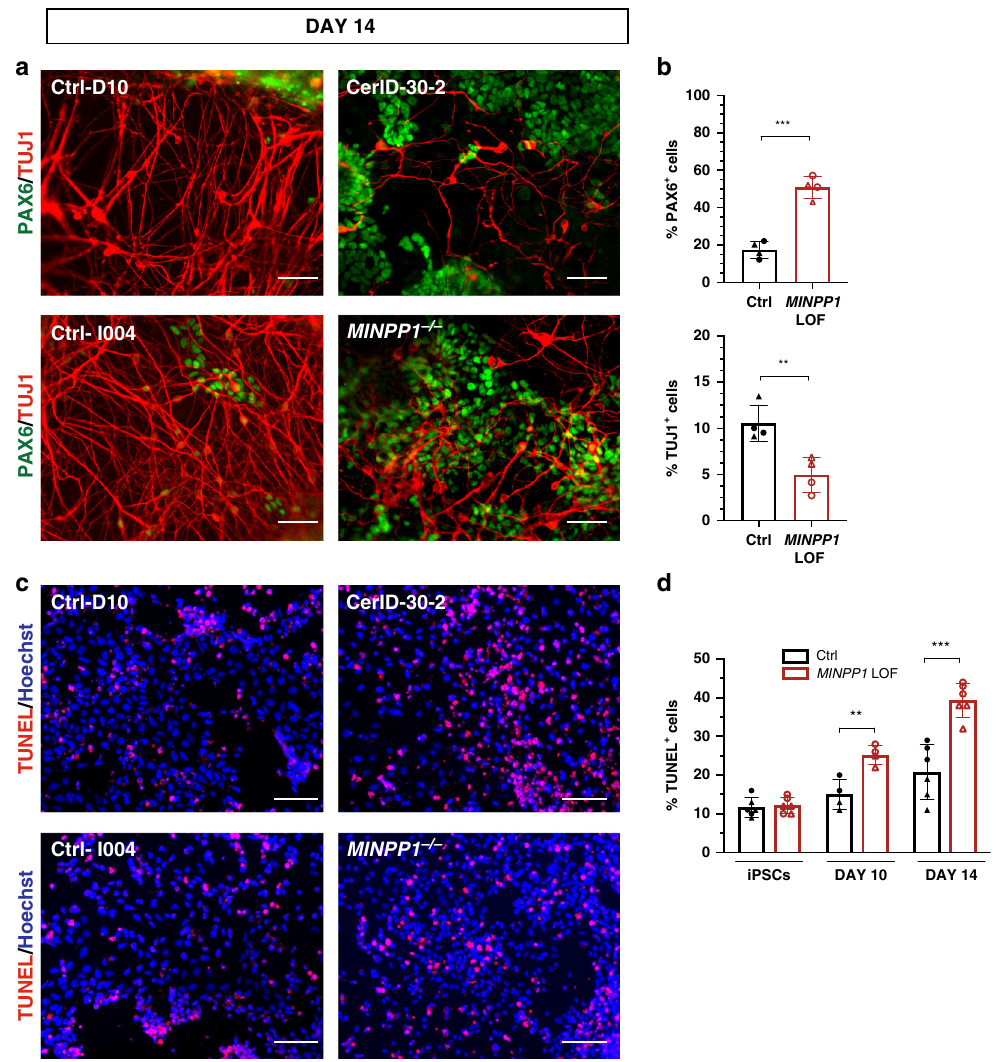
Fig. 3 MINPP1 loss causes an early neuronal differentiation defect combined with an increase in apoptosis. a Control (Ctrl-D10 ( fi lled circle) and Ctrl- I004 ( fi lled triangle)) and MINPP1 LOF (patient-derived (CerID-30-2 (blank circle) and MINPP1 − / − (blank triangle)) iPSCs were differentiated toward neuronal lineage for 14 days. Representative images of the differentiated cells stained with early neuronal marker TUJ1 and neural progenitor marker PAX6. Hoechst was used as a nuclear stain. b Quantitative analysis of the immuno fl uorescence data. c Representative images of TUNEL staining during neuronal differentiation at day 14. d Quanti fi cation of the TUNEL assay during neuronal differentiation (iPSC, day 10 and day 14). All scale bars correspond to 50 μ m. (For ( b , c ), n = 4, for ( d ), n = 6 for iPSCs and day 14, n = 4 for day 10. Duplicate/triplicate analysis of two independent experiments. Two-tailed student ’ s t - test, ** p ≤ 0.01 and *** p ≤ 0.001. For ( b ) upper panel, Ctrl vs. MINPP1 LOF: p = 0.0001; for ( b ) lower panel, Ctrl vs. MINPP1 LOF: p = 0.0066; for day 10 data ( d ), Ctrl vs. MINPP1 LOF: p = 0.0045 and for day 14 data ( d ), Ctrl vs. MINPP1 LOF: p = 0.0003). The data are presented as mean percentage values